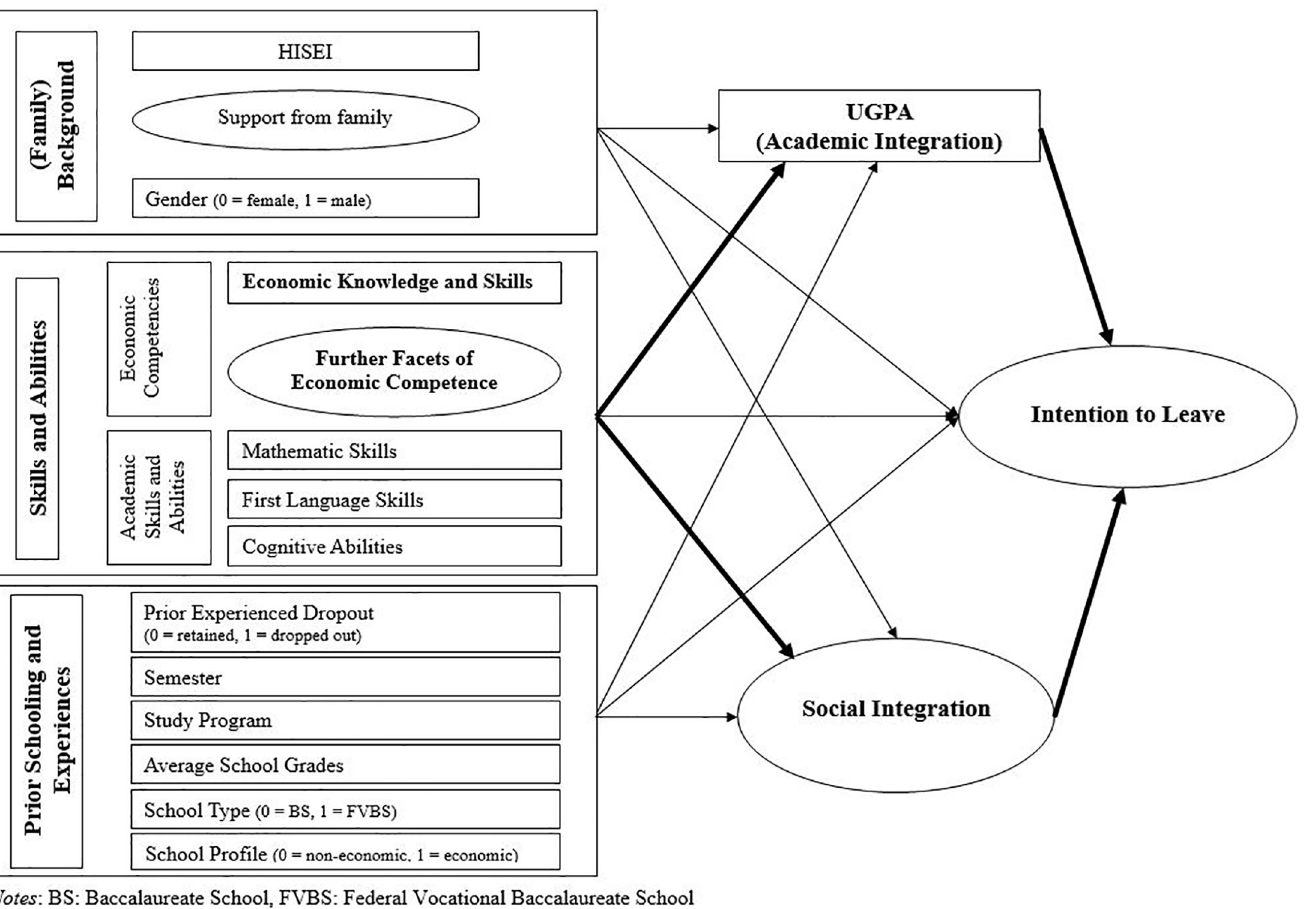
Fig 2. Empirical model to test the effects of economic competencies on the intention to leave economics studies at university. BS = Baccalaureate School, FVBS = Federal Vocational Baccalaureate School.